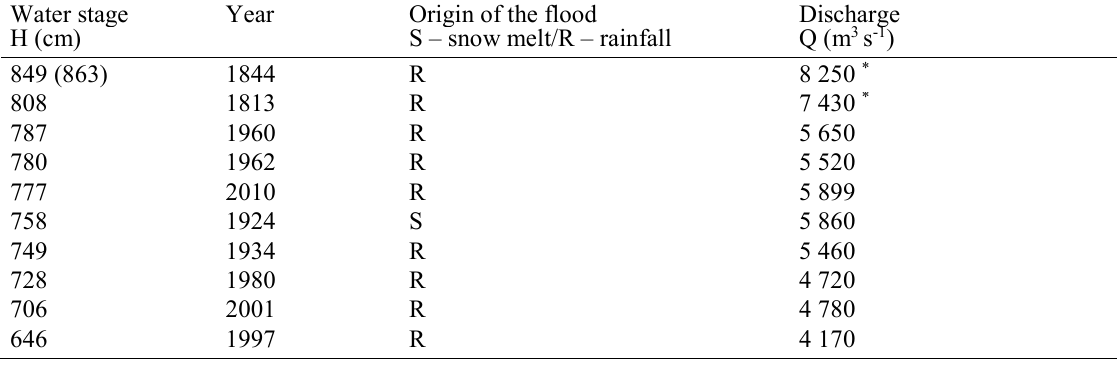
Table 1 High water stages and corresponding discharge of the Vistula River in Warsaw profile (Port Praski) 1813–2010: 1 – obtained from retro-modelling by CCHE2D; *value from retro-modelling Water stage H (cm)